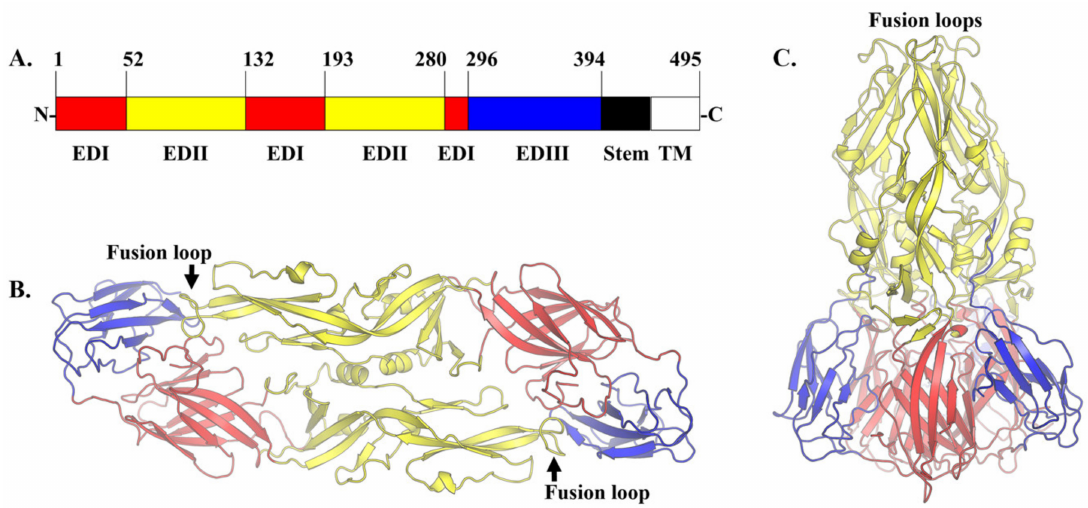
Figure 2. The envelope (E) glycoprotein. ( A ) The discontinuous domains of dengue E protein. Domain I (EDI) is in red, domain II (EDII) is in yellow and domain III (EDIII) is in blue. The stem region and the transmembrane (TM) domain spanning amino acids 394–495 are represented in black and white, respectively. ( B ) The E protein dimer in the mature DENV2 virion and in an environment with neutral pH (PDB ID: 1OAM). ( C ) The structure of trimeric DENV1 E protein in its postfusion conformation. The domains have rotated and shifted with EDIII undergoes the most significant rearrangement with 70 ◦ folding towards EDI and EDII (PDB ID: 4GSX). The fusion loop is buried at the dimer interface in mature virion. In contrast, the fusion loop is exposed at the tip of the E protein trimer in